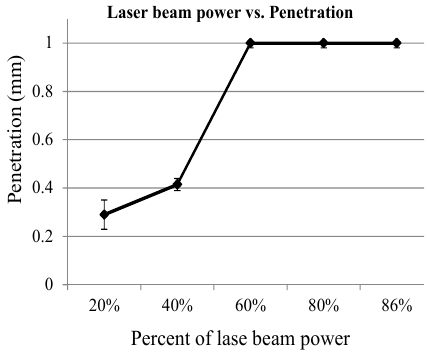
Figure 9. The effects of laser beam power on penetration.